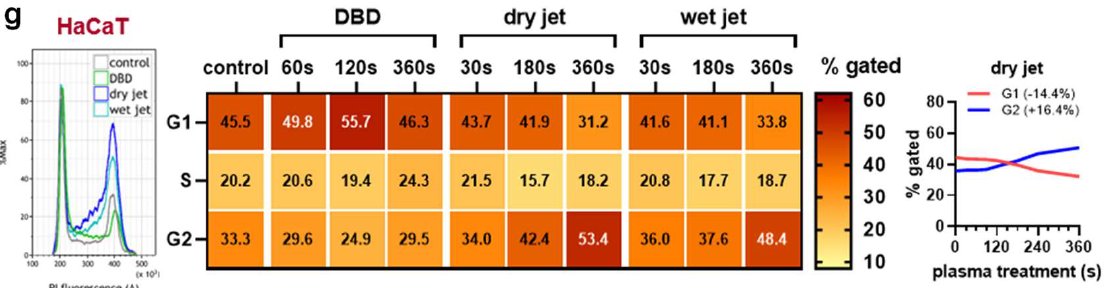
Figure 1. Metabolic activity decline and cell cycle rest of glioblastoma monocultures in vitro. ( a ) study scheme; ( b ) H 2 O 2 generation by the DBD and the jet operated with dry and humid (wet) argon gas; ( c ) cellular oxidation as indicated by DCF fluorescence upon exposure to plasma-treated media; ( d , e ) representative macroscopic image of the resazurin assay ( d ) and metabolic activity quantified and normalized ( e ) against each untreated control for HaCaT keratinocytes, HaCaTs with a history of plasma exposure and passaging (LT) and malignant T98G GBM cells; ( f , g ) representative flow cytometry overlay histograms of propidium iodide (PI) fluorescence (left), quantification of cell cycle phases using mathematically modeling (middle), and spaghetti plots of the same data visualizing G1 to G2 ratios for T98G ( f ) and HaCaT ( g ) cells. Data are representative of boxplot or mean and standard error of three experiments; statistical analysis was performed using unpaired, two-tailed t -test with p < 0.05 (*) and p < 0.001 (***) differing significantly or non-significantly (ns).